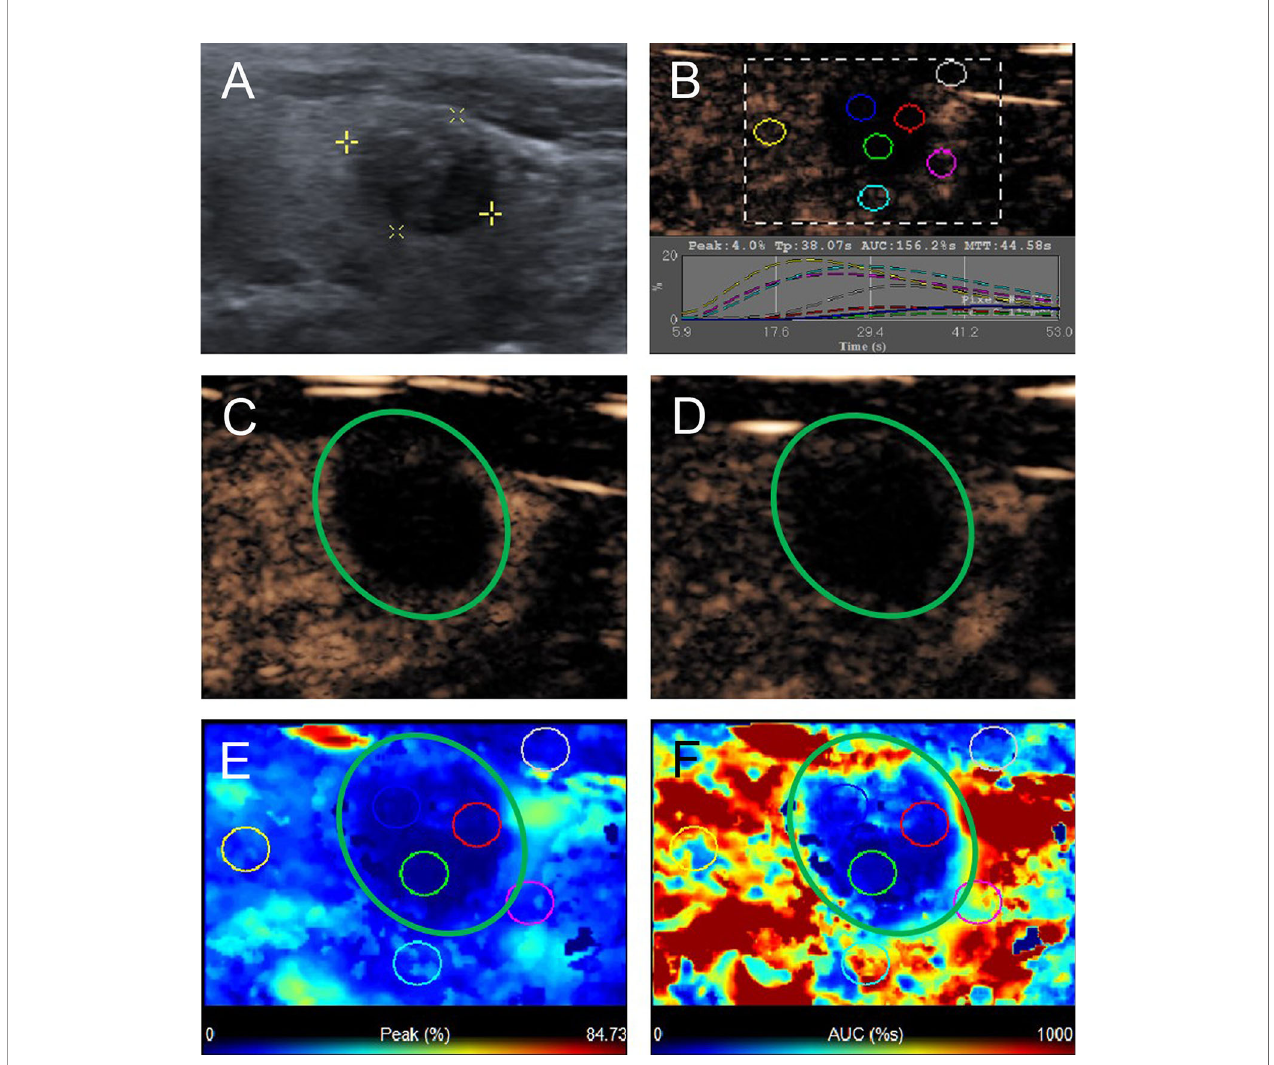
FIGURE 4 | A 58-year-old man with C pattern mummi fi ed thyroid nodule proven by FNAB. (A) Nodule showed solid component and hypoechogenicity (TI-RADS 4b). (B) Time-intensity curve showed the CEUS parameters of this nodule compared with peripheral thyroid parenchyma. (C) The early phase and (D) the late phase of CEUS showed no microbubbles enter the nodule (green circle). (E) Parametric color map showed the values of peak for the nodule was completely deep blue, indicated the peak intensity of the nodule was markedly lower than peripheral thyroid parenchyma. (F) Parametric color map showed that the AUC for the nodule was totally deep blue compared with the surrounding red color of thyroid parenchyma, indicated AUC of the nodule was obviously lower than peripheral thyroid parenchyma.